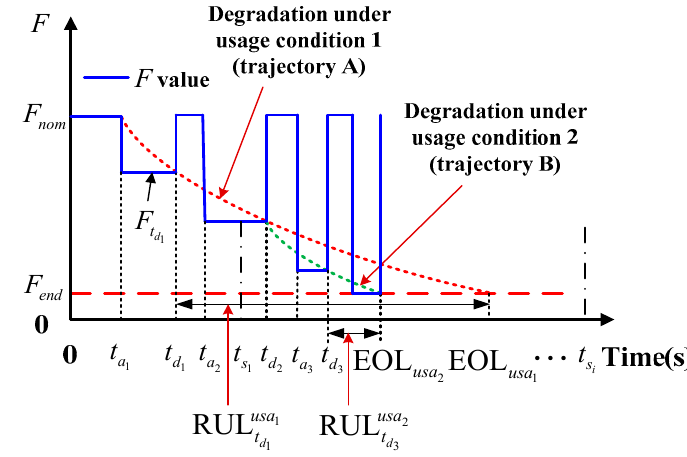
Figure 3. Usage dependent degradation process of intermittent fault.